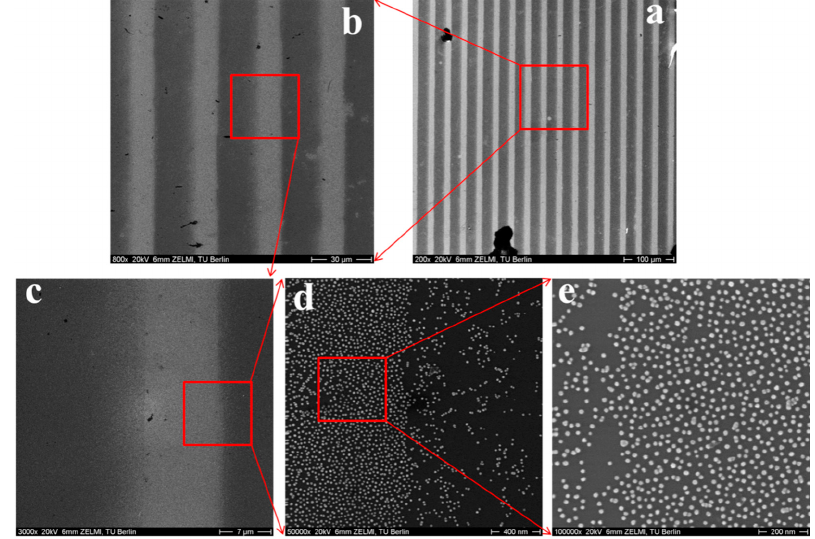
Figure 6 . SEM images of patterned Au NPs on the surface 8PEG-VS-SH hydrogels. Scale bar ( a ) 100 μ m; ( b ) 30 μ m; ( c ) 7 μ m; ( d ) 400 nm; ( e ) 200 nm. The size of Au NPs is 20 nm, and the distance between patterned stripes is 20 μ m in the swollen state.